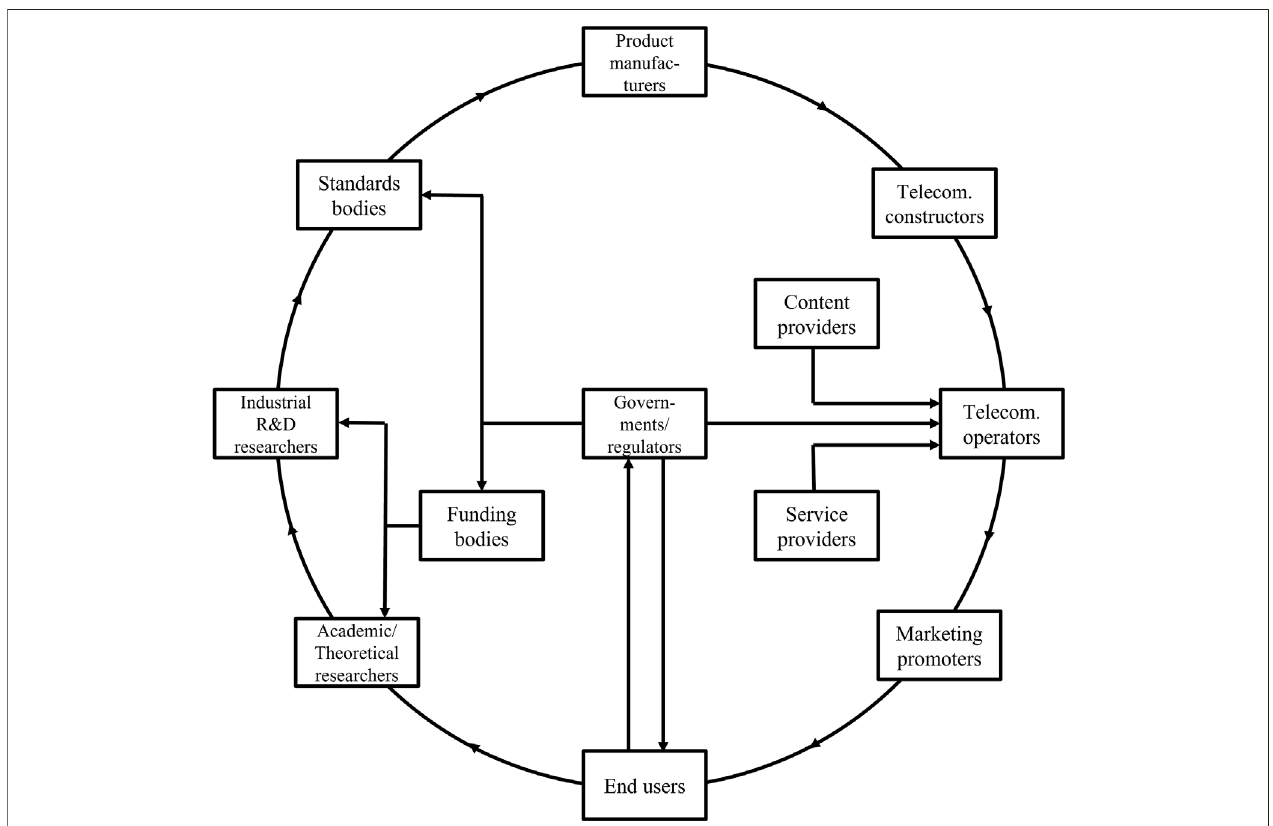
FIGURE 5 | Value loop associated with the BigCom framework and connecting